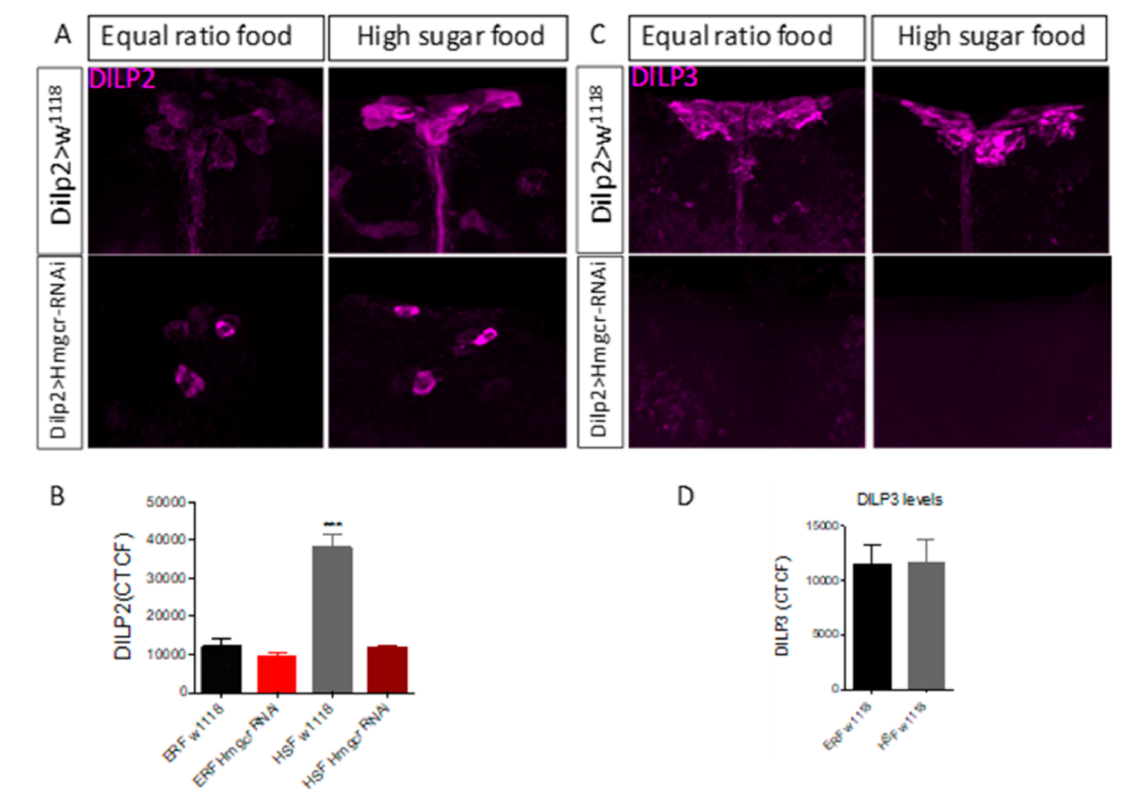
Figure 2. Loss of Hmgcr expression in the IPCs affects ILP protein levels. ( A , B ) In 5–7 day old control male flies ( Dilp2-GAL4 > w 1118 ), the high-sugar diet (58 g/dL sugar:12 g/dL protein) increased DILP2 protein levels in the pars intercerebralis IPCs compared to equally aged male flies fed a low-sugar diet (10 g/dL sugar:10 g/dL protein). In equally aged 5–7 day old Hmgcr males ( Dilp2-GAL4 > UAS-Hmgcr RNAi ) on either diet, DILP2 protein is expressed in only a few pars intercerebralis IPCs. ( C , D ) DILP3 protein expression was not affected by either diet in 5–7 day old control male flies, but DILP3 protein was abolished in an equally aged experimental group ( Dilp2-GAL4 > UAS-Hmgcr RNAi ) under both conditions. ( B , D ) CTCF: corrected total cell